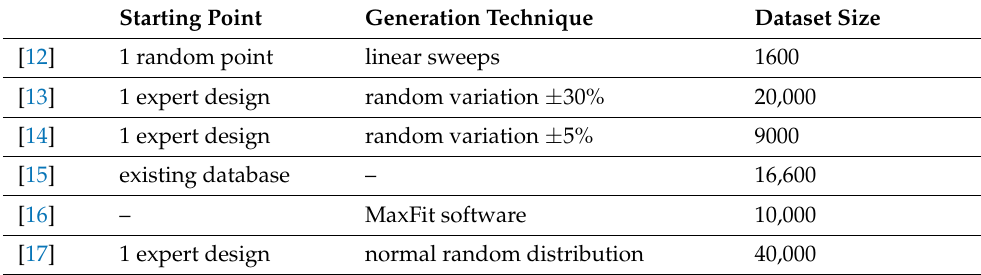
Table 2. Different dataset-generation methods used in prior state-of-the-art.